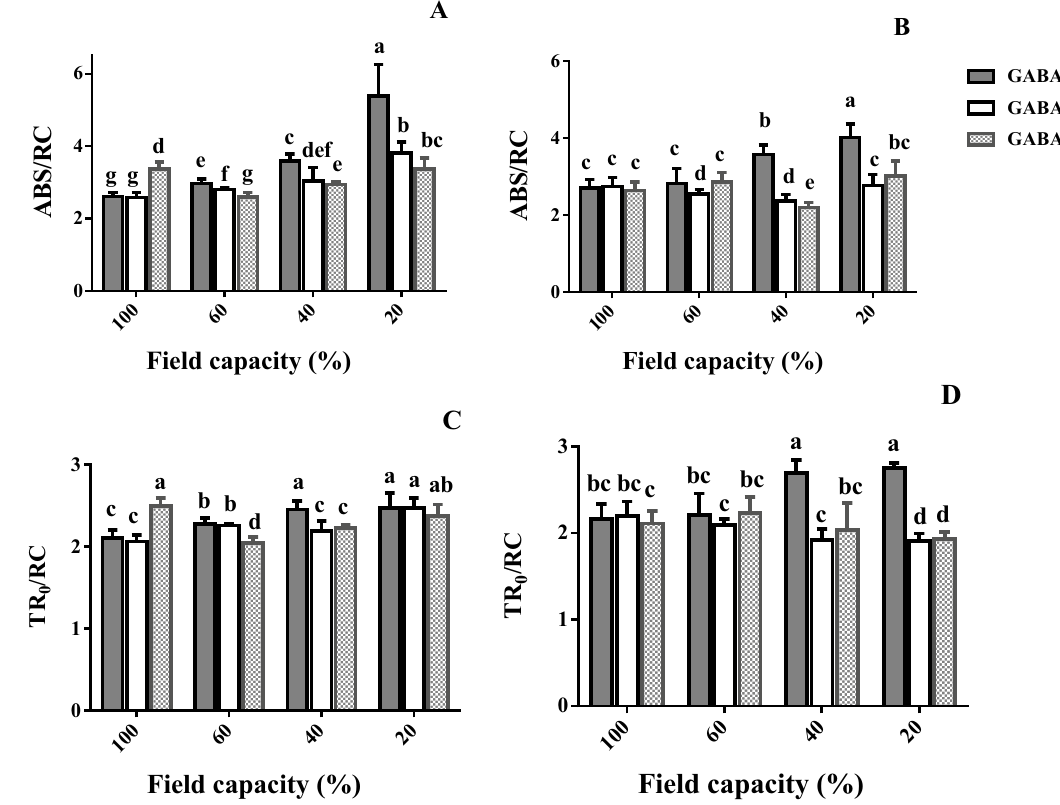
Figure 10. Leaf specific energy fluxes per reaction center for energy absorption (ABS/RC; A , B ) and trapped energy flux (TR 0 /RC; C , D ) of cv. Arman (tolerant; left panels) and cv. Azad (sensitive; right panels) chickpea plants receiving exogenous application of γ-aminobutyric acid (GABA) at different concentrations (0, 25 and 50 μM) under different watering levels (100, 60, 40 and 20% field capacity) during cultivation. Within each insert, different letters indicate significant differences. Error bars indicate SEM (n =